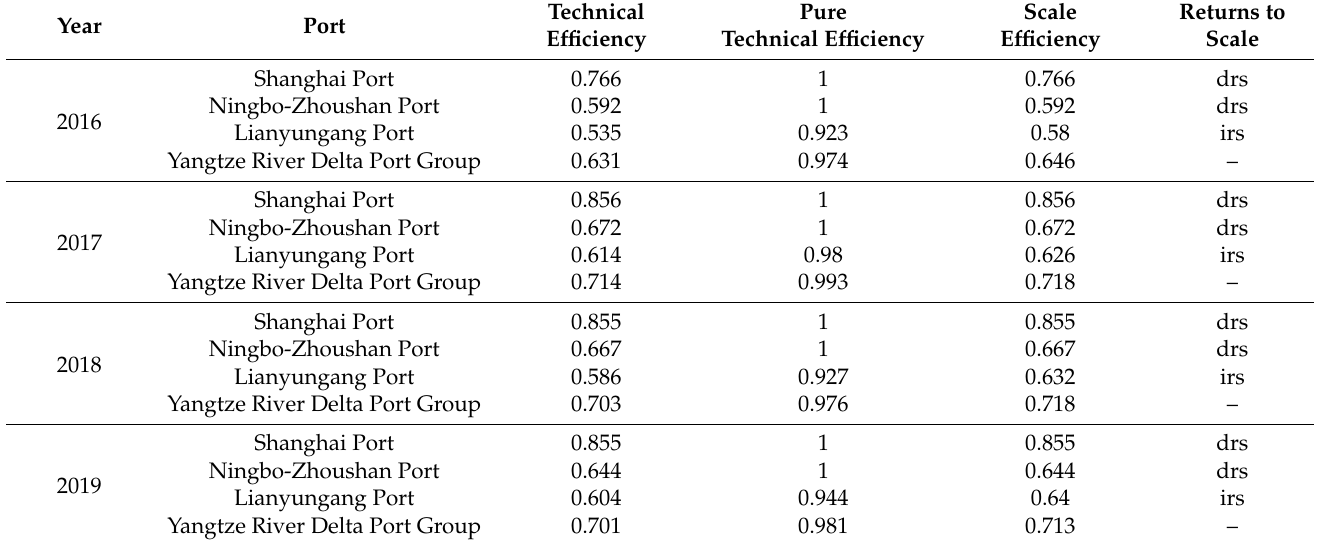
Table 6. The efficiency values of the Yangtze River Delta coastal port group from 2016 to 2020 in the third